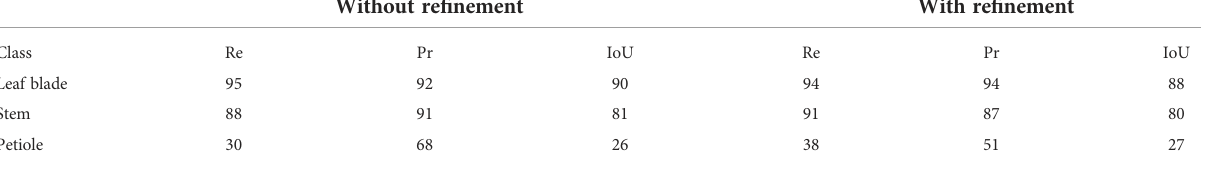
TABLE 2 Semantic segmentation results (in % ) on the synthetic Chenopodium data set, without and with the re fi nement stage explained in Section 3.4. Without re fi nement